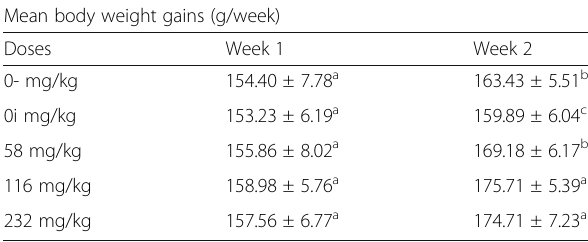
Table 6 Trends in mean body weight gains of rats during 2 weeks of